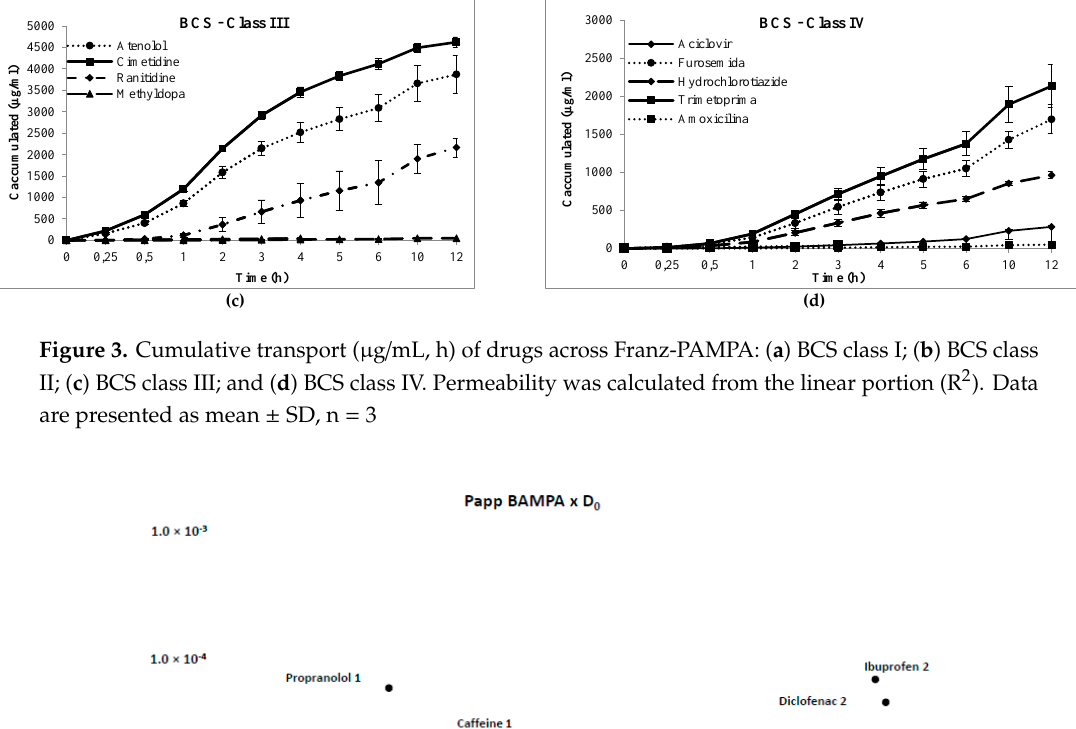
Figure 5. Papp calculations using equations by ( a ) per Artursson non-sink versus sink conditions and, ( b ) per Artursson non-sink compared to sink conditions best fit method of the linear portion.